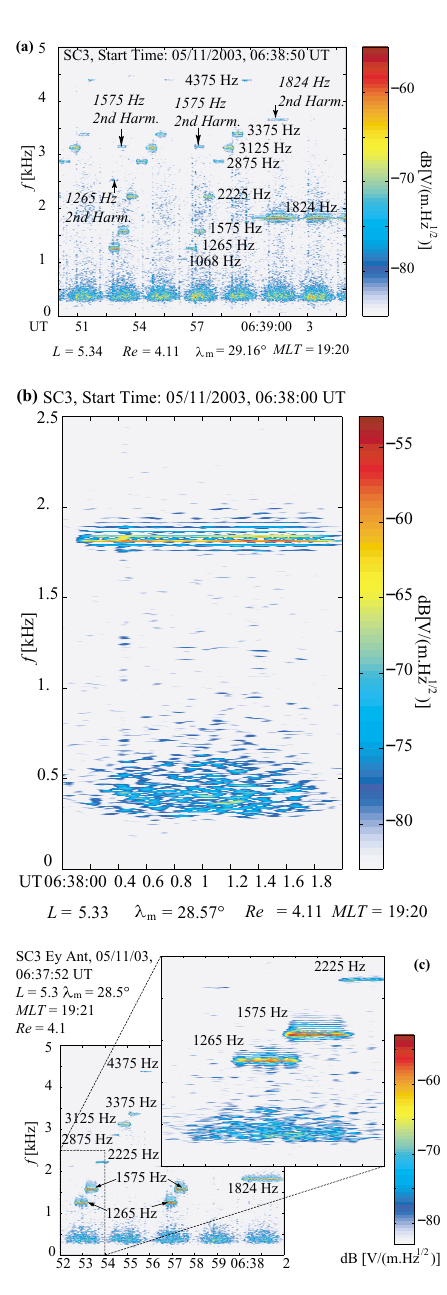
Fig. 10. Detailed WBD spectrograms from the Cluster satellite pass during 11 May 2003. (a) An overview of the detected HAARP sig- nal, including the harmonics generated by the HF heater. The whole transmitted pattern at all frequencies is observed, as well as side- band waves appearing around the stronger pulses. (b) An overview of the detected HAARP signal at 1824Hz, showing sideband waves generated around the long 12-s pulse and the characteristic “spin fade”. (c) Detailed spectrogram of two of the stronger pulses at fre- quencies 1265Hz and 1575Hz. The zoom-in shows the sideband waves, which extend several hundred Hz above and below the nom- inal frequency. Also notice the spin modulated baseband noise. The magnitude scale refers to electric field